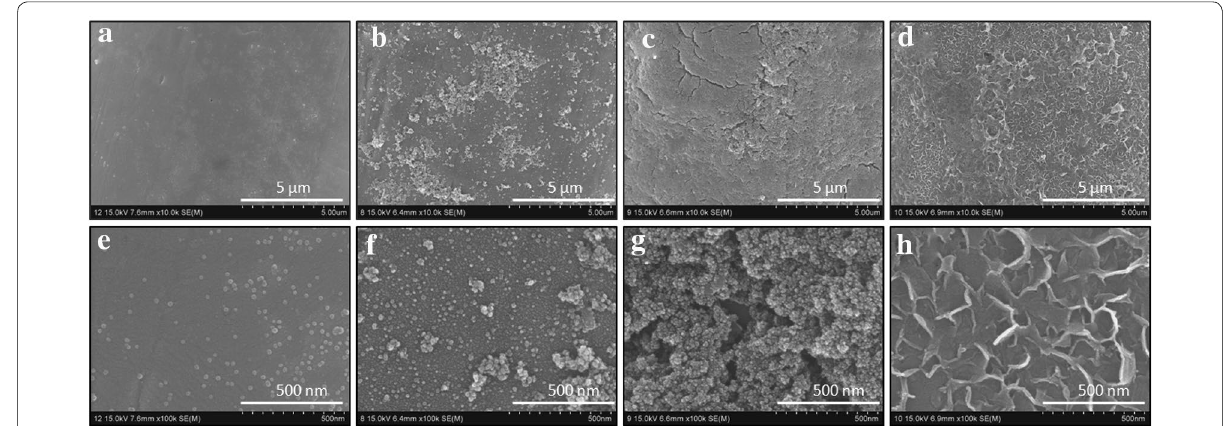
Fig. 1 FESEM images of the surface‑modified SMSSM substrate at different etching of a 0%, b 0.5%, c 1% and d 1.5% at the (5 µm scale bar), e – h the magnified local images at high magnifications [